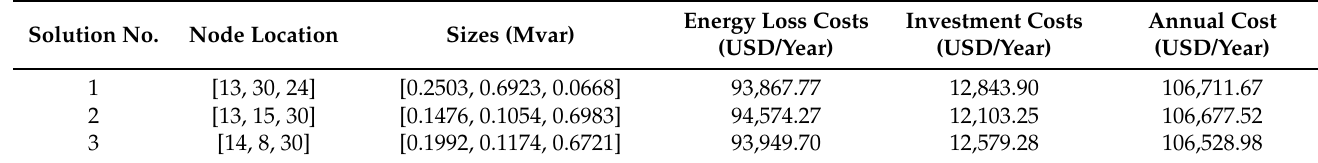
Table 5. List of best results obtained for a radial configuration with the proposed methodology. Solution